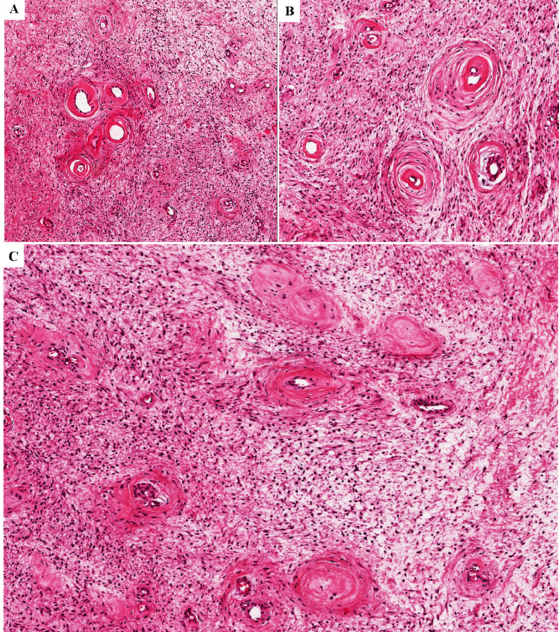
Figure 6. Perivascular hyalinization in primary DAM : ( A ) Small-sized and medium-sized blood vessels showing deposition of hyalinized eosinophilic collagen around the walls. ( B ) Perivascular cuffing of spindled cells with an onion-skin arrangement is also observed. ( C ) Some blood vessels showing fibro-sclerotic obliteration of the vascular lumens. In (iv) three cases, microcystic/reticular stromal changes were observed (Figure 7).